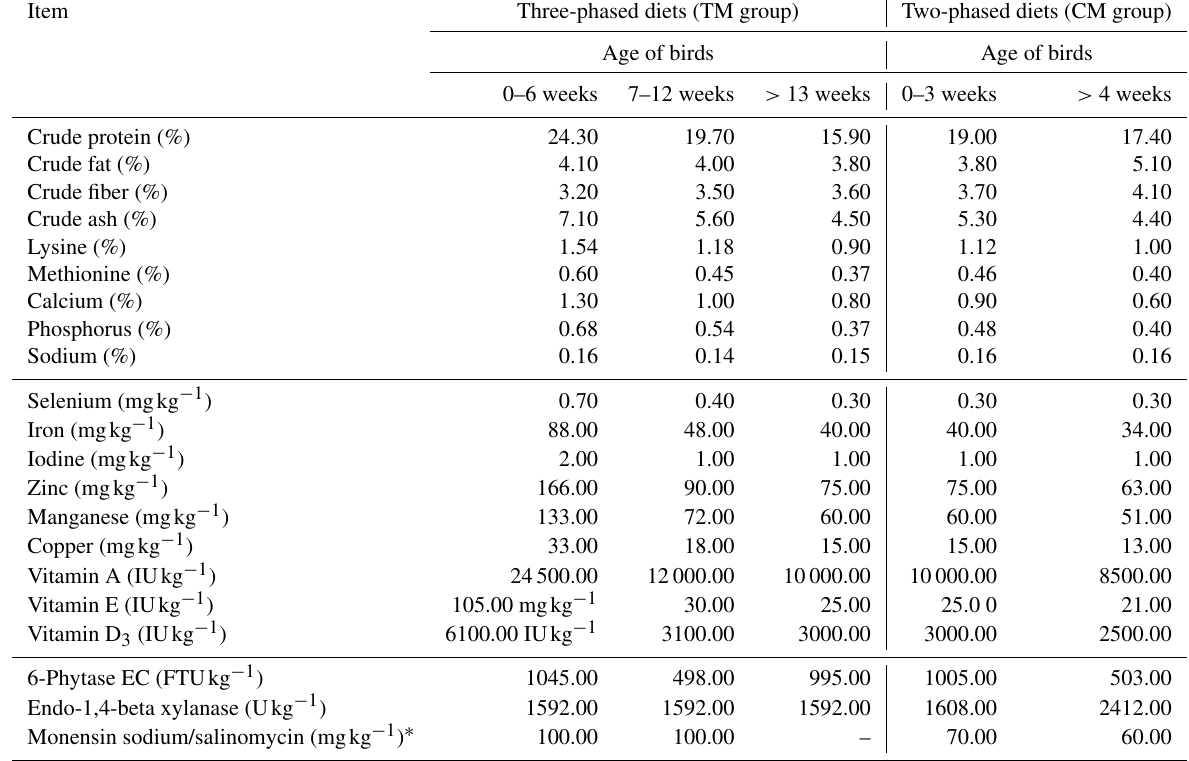
Table 1. The composition of feed mixture dedicated for turkeys and chickens depending on the birds’ age.